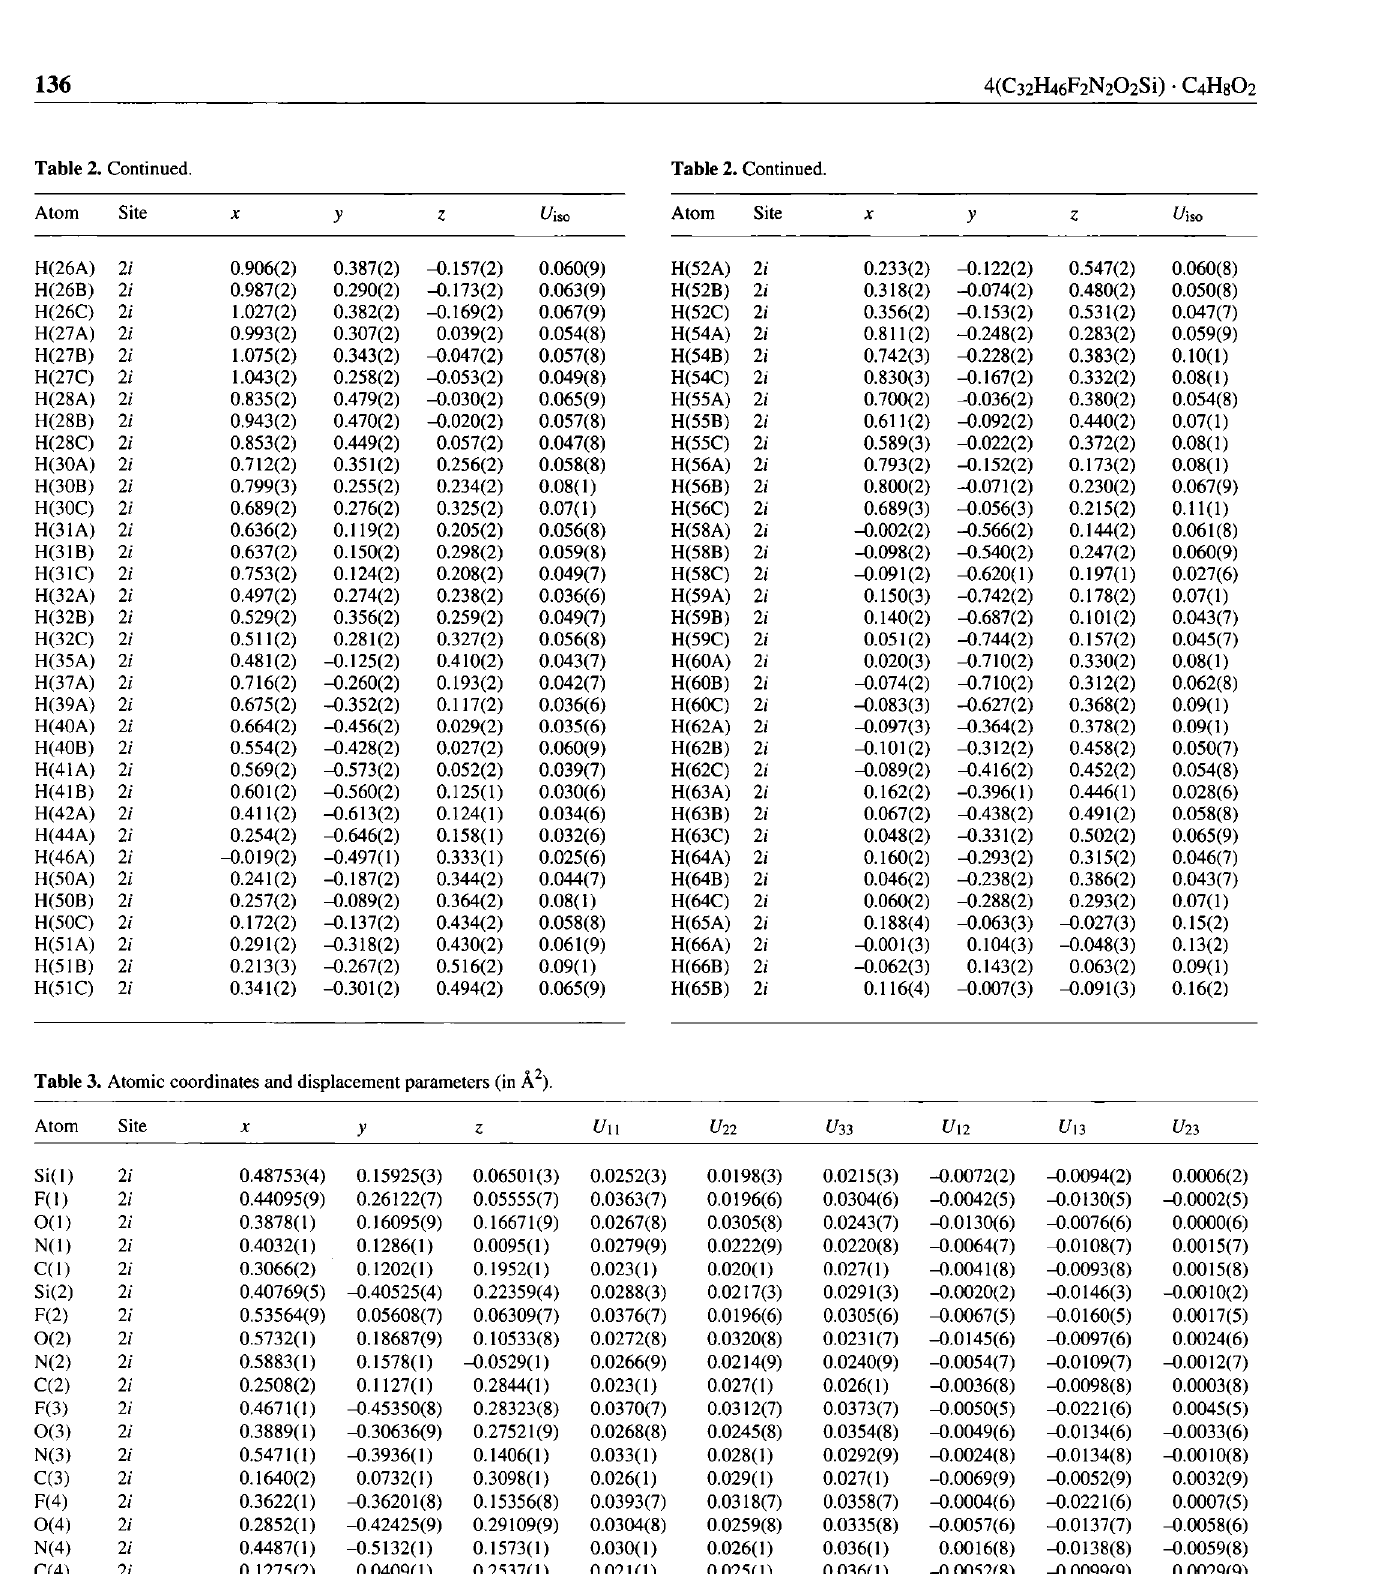
Table 3. Atomic coordinates and displacement parameters (in Ä 2